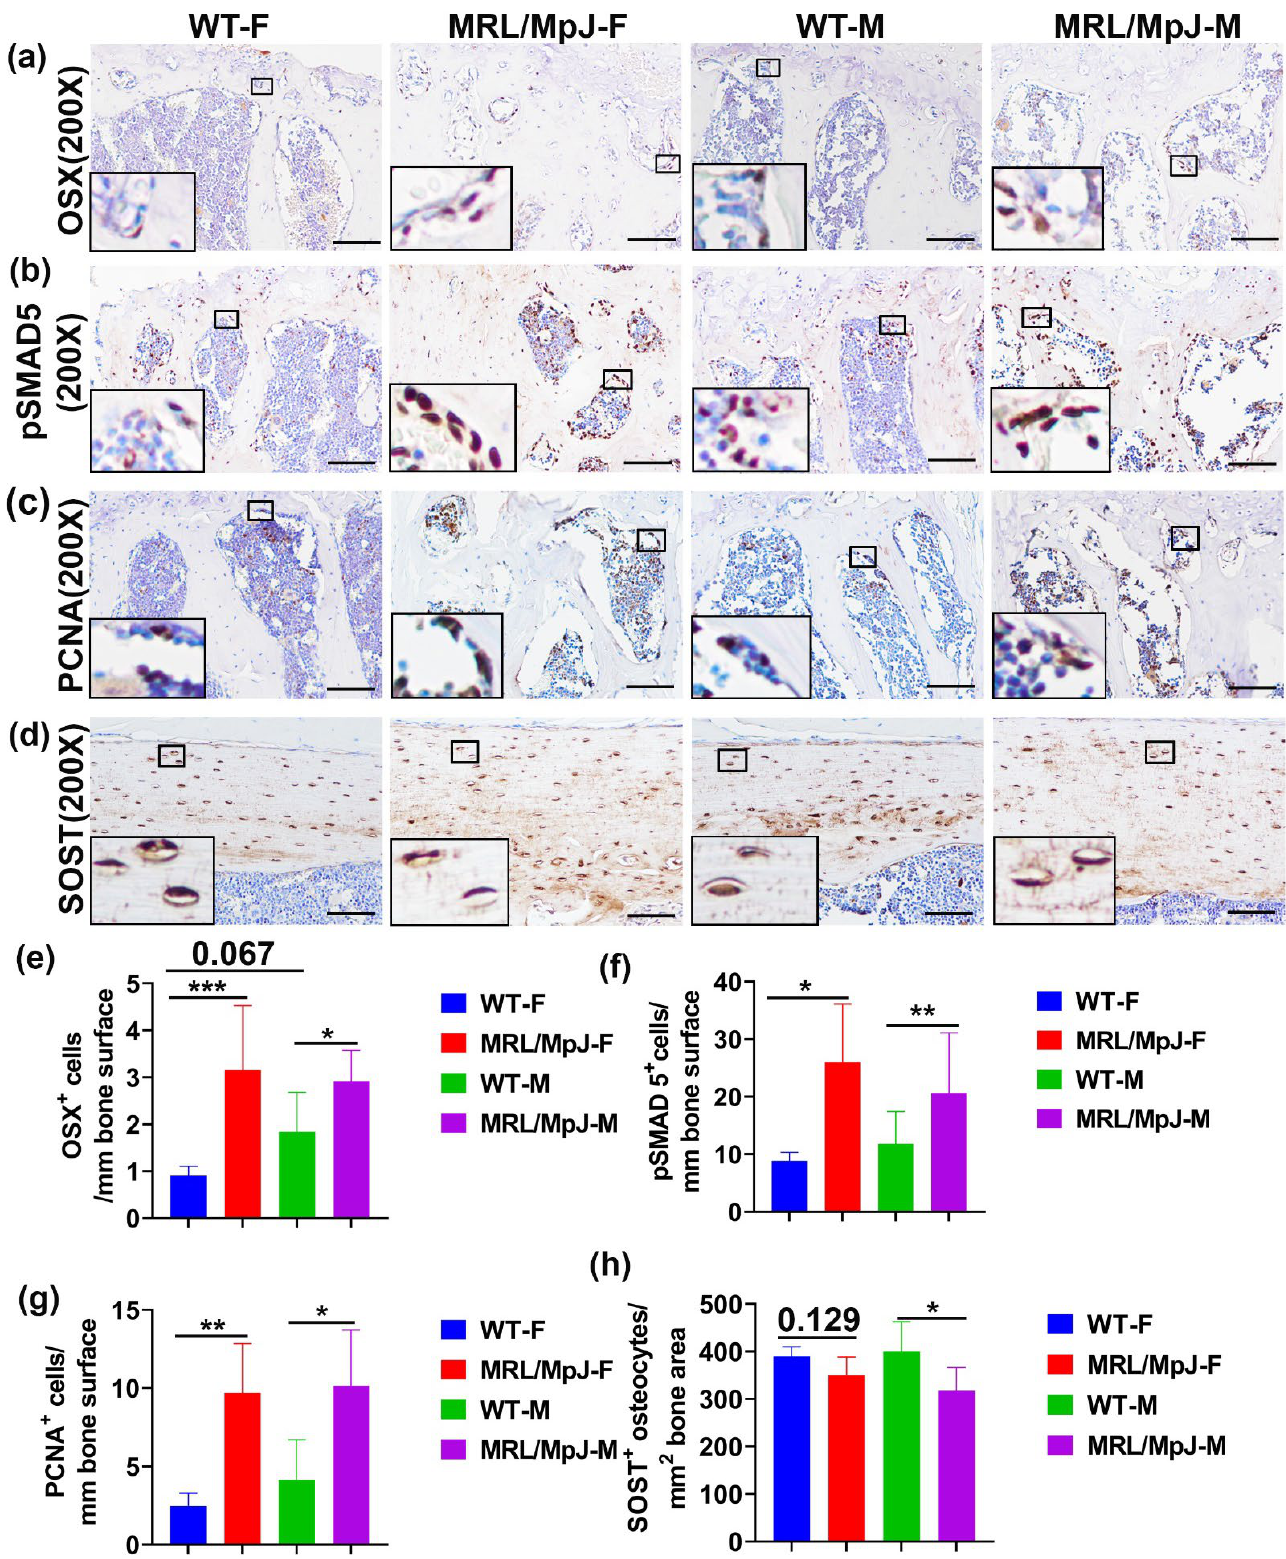
Figure 3. Immunohistochemical staining of 14 M bone tissues. ( a , e ) Immunohistochemistry staining of OSX in the L6 vertebra with quantification. OSX + cells are stained brown (DAB) and nuclei are stained blue. Bone surface OSX + cells in MRL/MpJ-F and MRL/MpJ-M mice were significantly greater than in WT-F and WT-M mice. There was a trend of increased bone surface OSX + cell in WT-M mice